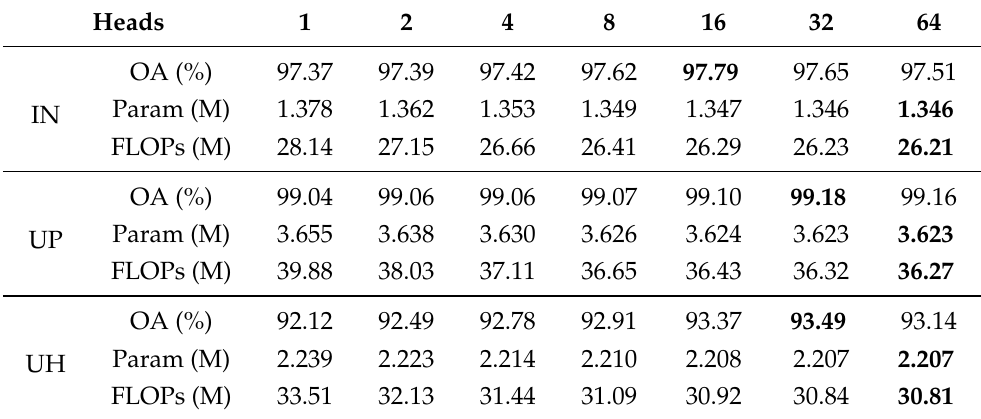
Table 2. Ablation study with different numbers of channel grouping and corresponding spatial attention heads ranging from 1 to 64. The best results are highlighted in bold font.